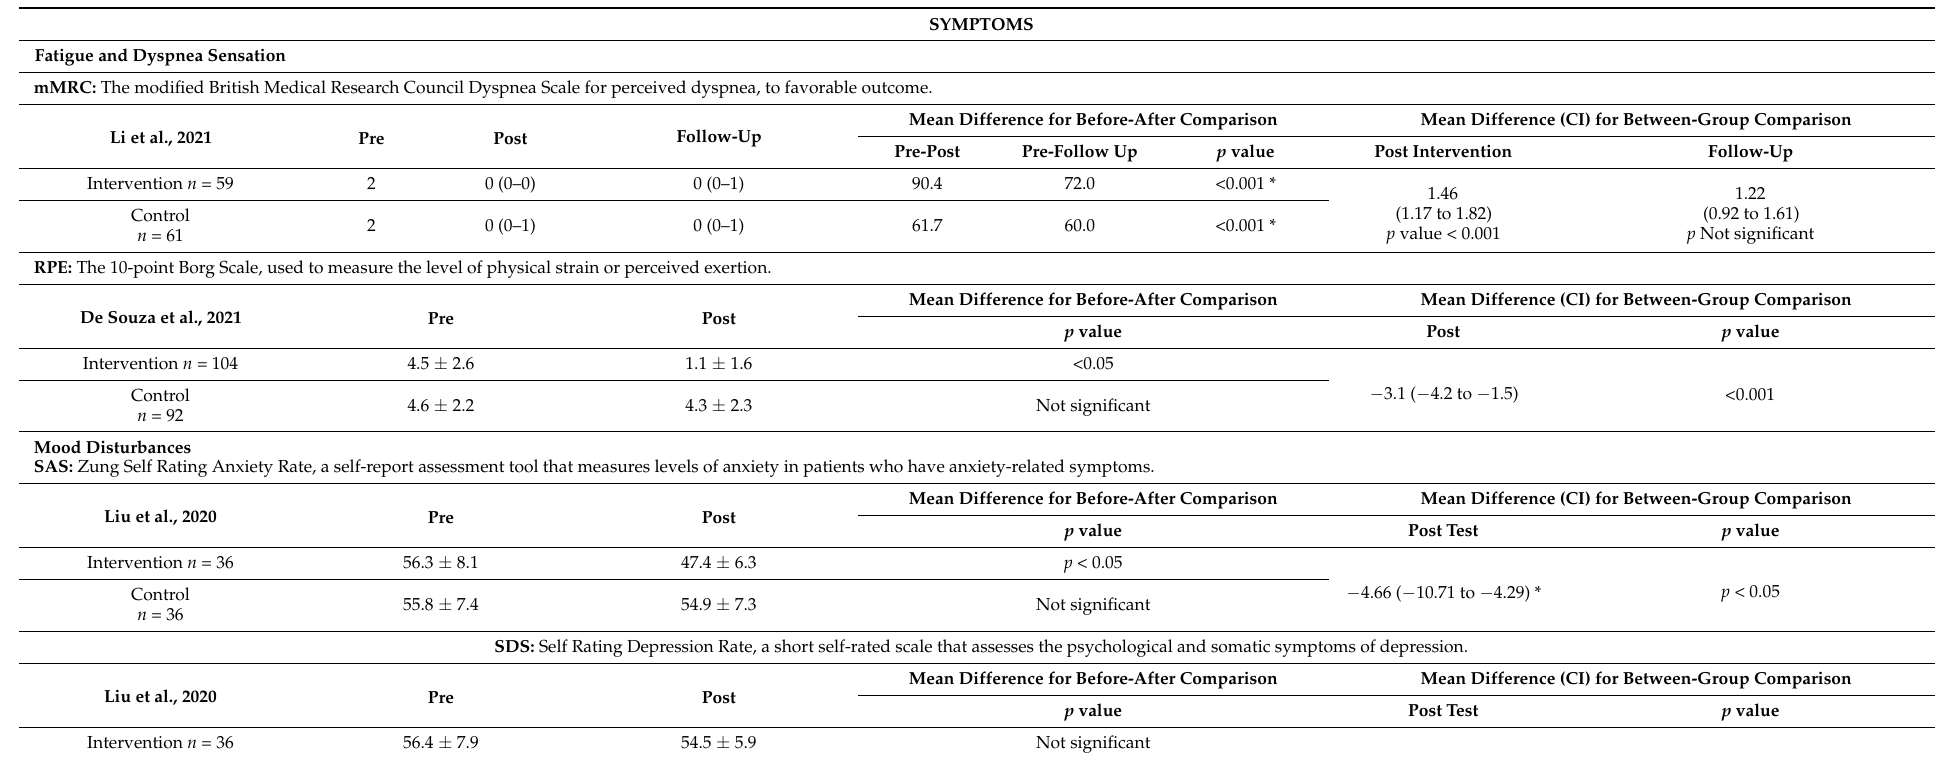
Table 2. Symptom-related